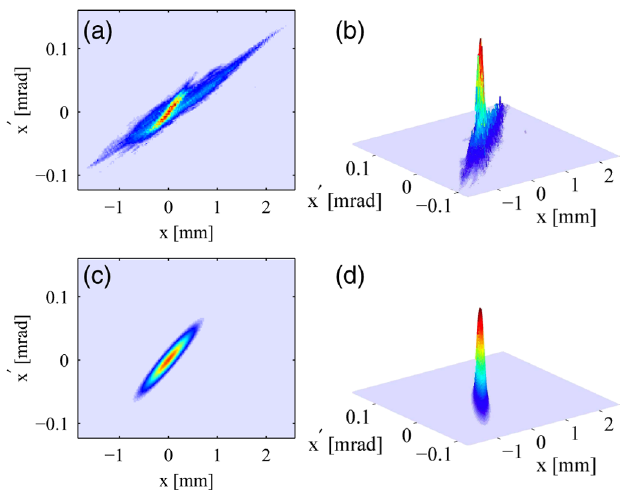
FIG. 18. (Color) (a) and (b): Measured distribution of a slice within the current spike at 494 MeV ( (cid:2) ¼ (cid:8) 7 (cid:1) m ). (c) and (d): Two-dimensional Gaussian fit to the high-intensity core.